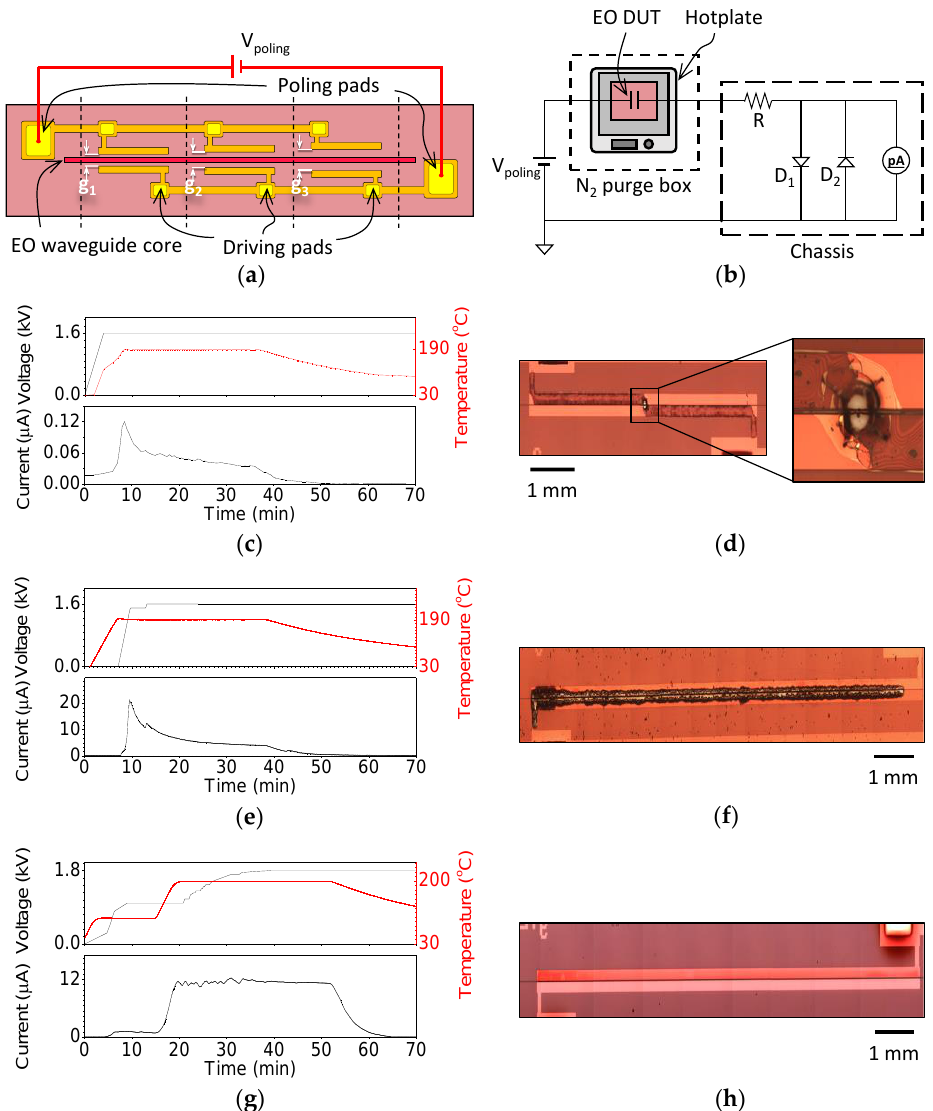
Figure 5. ( a ) Electrode design for efficient poling experiment, where three coplanar electrodes with different gaps are connected in parallel. Note that the aspect ratio of the electrode gap is exaggerated to show the concept clearly. ( b ) In the poling setup, the device is placed on a hotplate inside a nitrogen purge box connected to a picoammeter with an accidental high-current protection circuit. The voltage, temperature, and current profiles during the poling process and microscopic images of each sample: ( c ) profile when the voltage is increased to a high level before increasing the temperature; ( d ) electrode destroyed because of a defect near the electrode; ( e ) rapid rise in the voltage to a high poling voltage causing breakdown; ( f ) dielectric breakdown along the electrode; ( g ) stable poling profile without breakdown, by stepwise voltage and temperature control; ( h ) sample that survived the poling process.